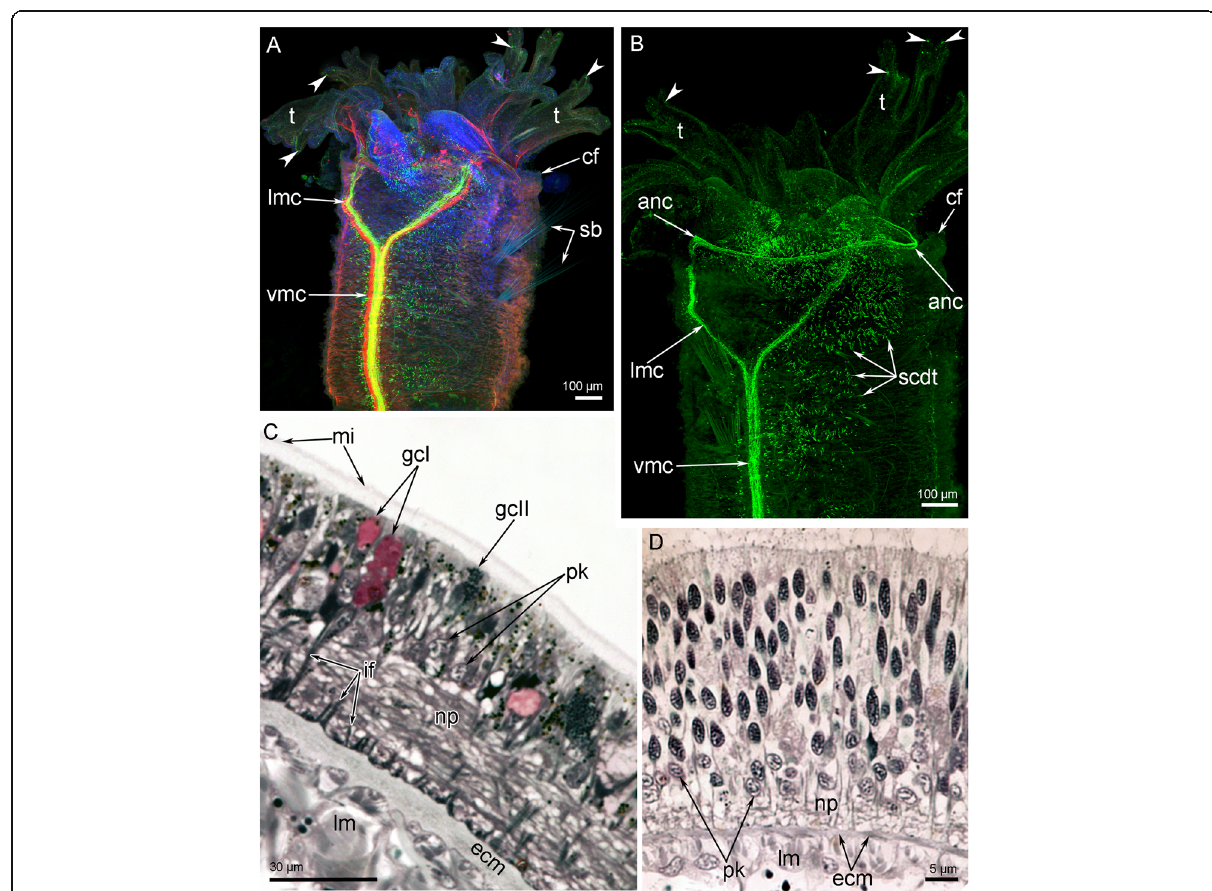
Fig. 7 Organization of the nervous system of the head of Owenia borealis . A General anatomy of the nervous system viewed from the ventral side: Z-projection after double immunostaining against acetylated alpha-tubulin (red) and serotonin (green) and staining with DAPI (blue). B Serotonin-lir nerve elements of the head viewed from the ventral side; Z-projection after immunostaining against serotonin (green). Some serotonin-lir cells in the epithelium of tentacles are indicated by arrowheads. C Semi-thin transverse section of the outer ring of the anterior nerve center. D Semi-thin transverse section of the inner (=circumoral) nerve ring of the anterior nerve center. Abbreviations: anc – outer ring of the anterior nerve center; cf. – collar fold; ecm – extracellular matrix; gcI – gland cell of first type; gcII – gland cell of second type; if – intermediated filaments; lm – longitudinal muscles; lmc – lateral medullary cord; mi – microvilli; np – neuropil; pk – perikarya; sb – setae bundle; scdt – serotonin-lir cells of the digestive tract; t – tentacle; vmc – ventral medullary